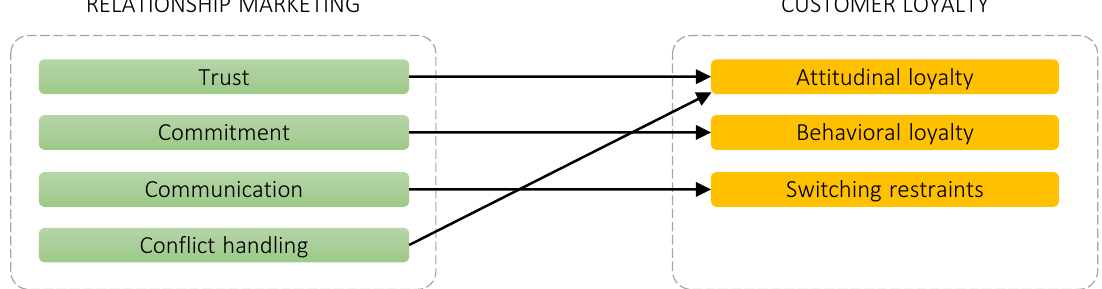
Figure 1. Conceptual